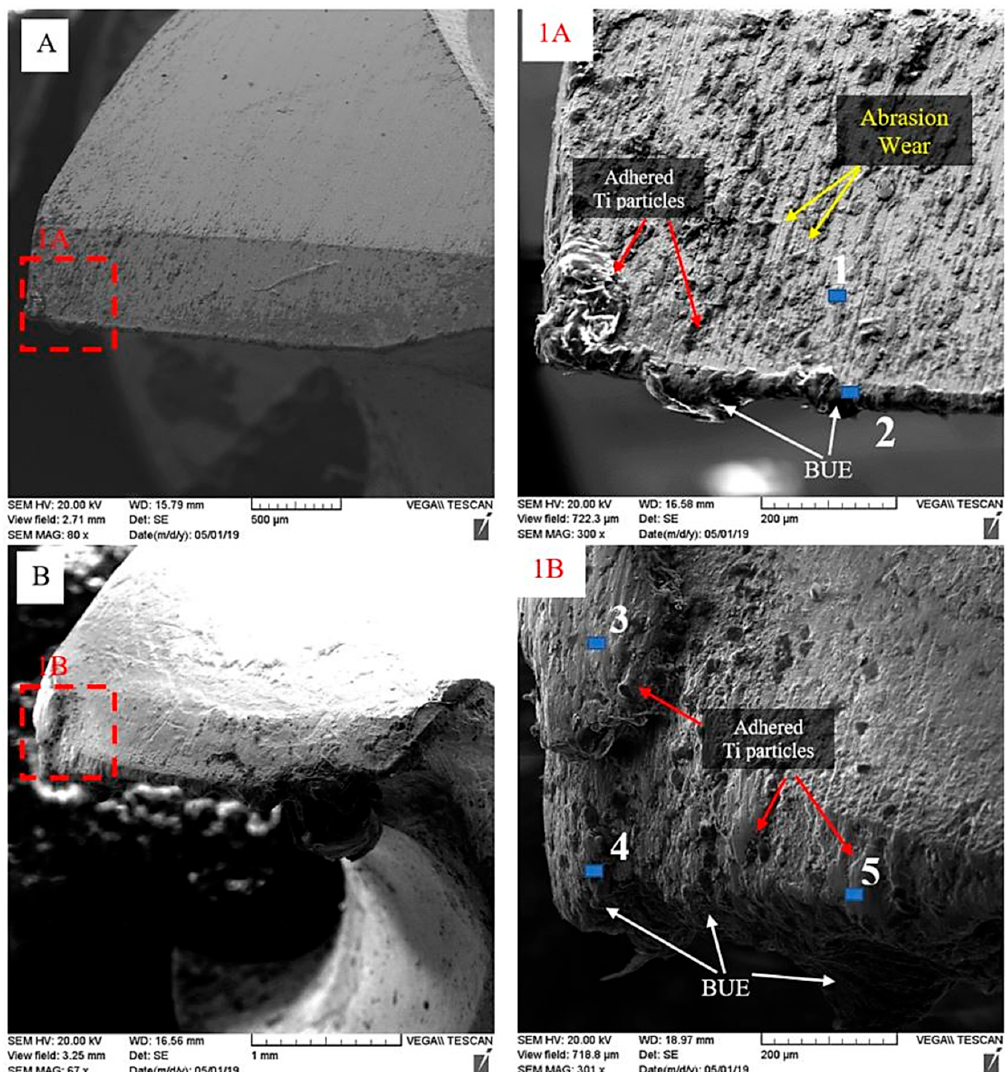
Figure 11. The SEM flank surface examination for ( A ) VAD at A m = 0.25 mm and ( B ) conventional drilling at N = 56.52 m/min and f = 0.025 mm/rev.